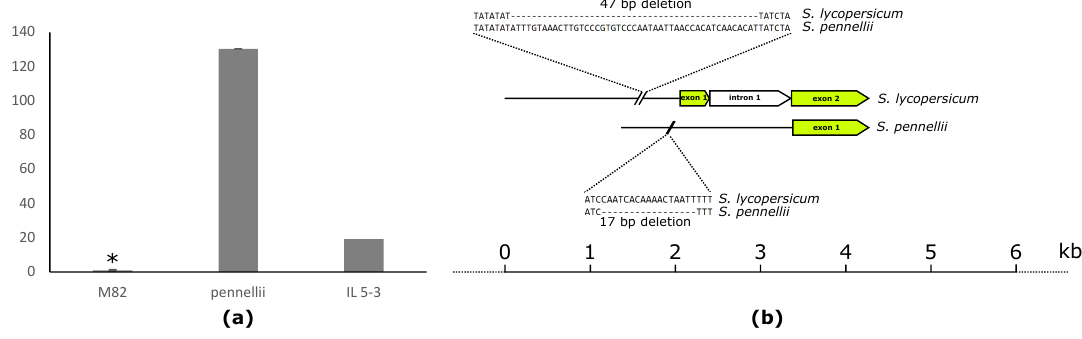
Figure 6. ( a ) Transcript levels of the cholesterol acyltransferase gene ( Solyc05g050710) in red ripe fruits of M82, Solanum pennellii , IL5-3. Expression of the gene in wild tomato species Solanum pennellii , similar to IL 5-3 expressing the same allele version, is higher compared to cultivated tomato variety M82. ( b ) Comparison between the promoter regions of allelic versions of Solyc05g050710 derived from cultivated tomato variety M82 and wild tomato Solanum pennellii . Deletions of 47 and 17 bp can be found in the promotor sequence of Solanum lycorepsicum and Solanum pennellii compared to the respective other. Asterisks indicate significant di ff erences (* p <